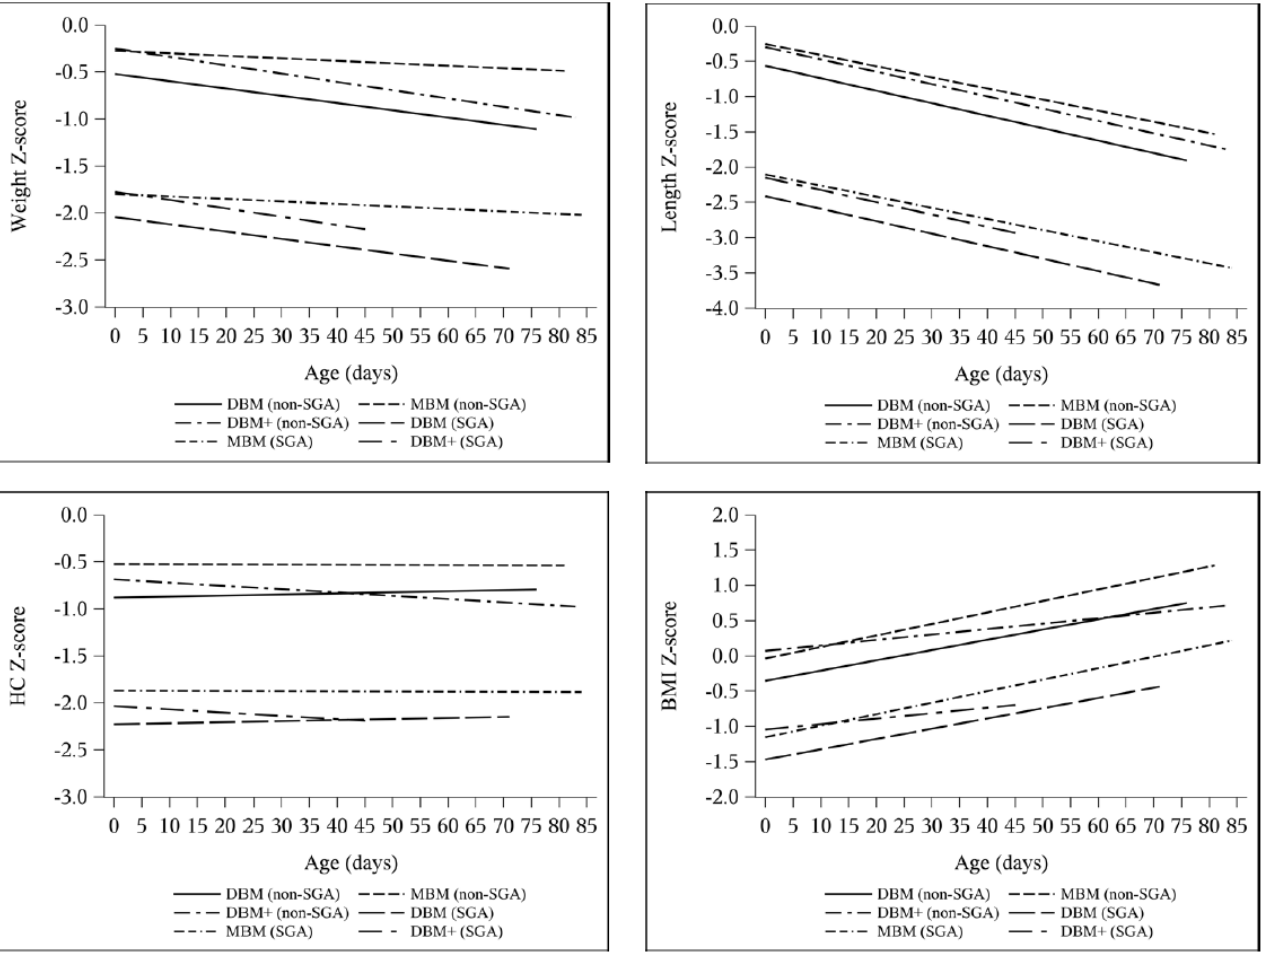
Figure 4. Adjusted longitudinal models of z-score change over time by cohort: non-SGA DBM ( n = 47), non-SGA MBM ( n